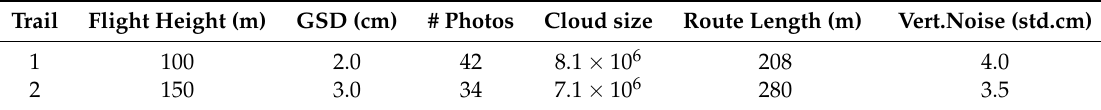
Table 1. Details of the photogrammetric data. GSD is provided by the GeoDrone manual. Vertical noise is an approximation of the vertical accuracy of the point cloud points. Trail Flight Height (m) GSD (cm) # Photos Cloud size Route Length (m) Vert.Noise